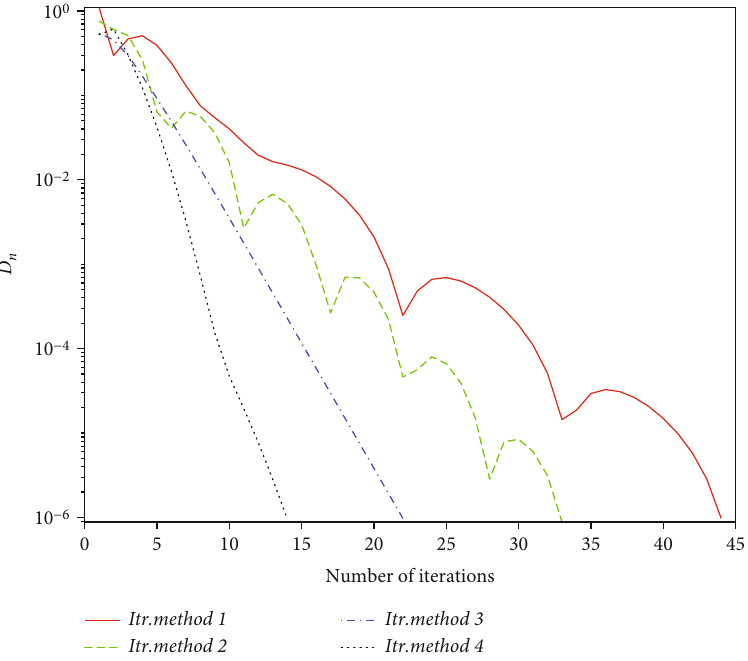
Figure 1: All methods are compared computationally while x